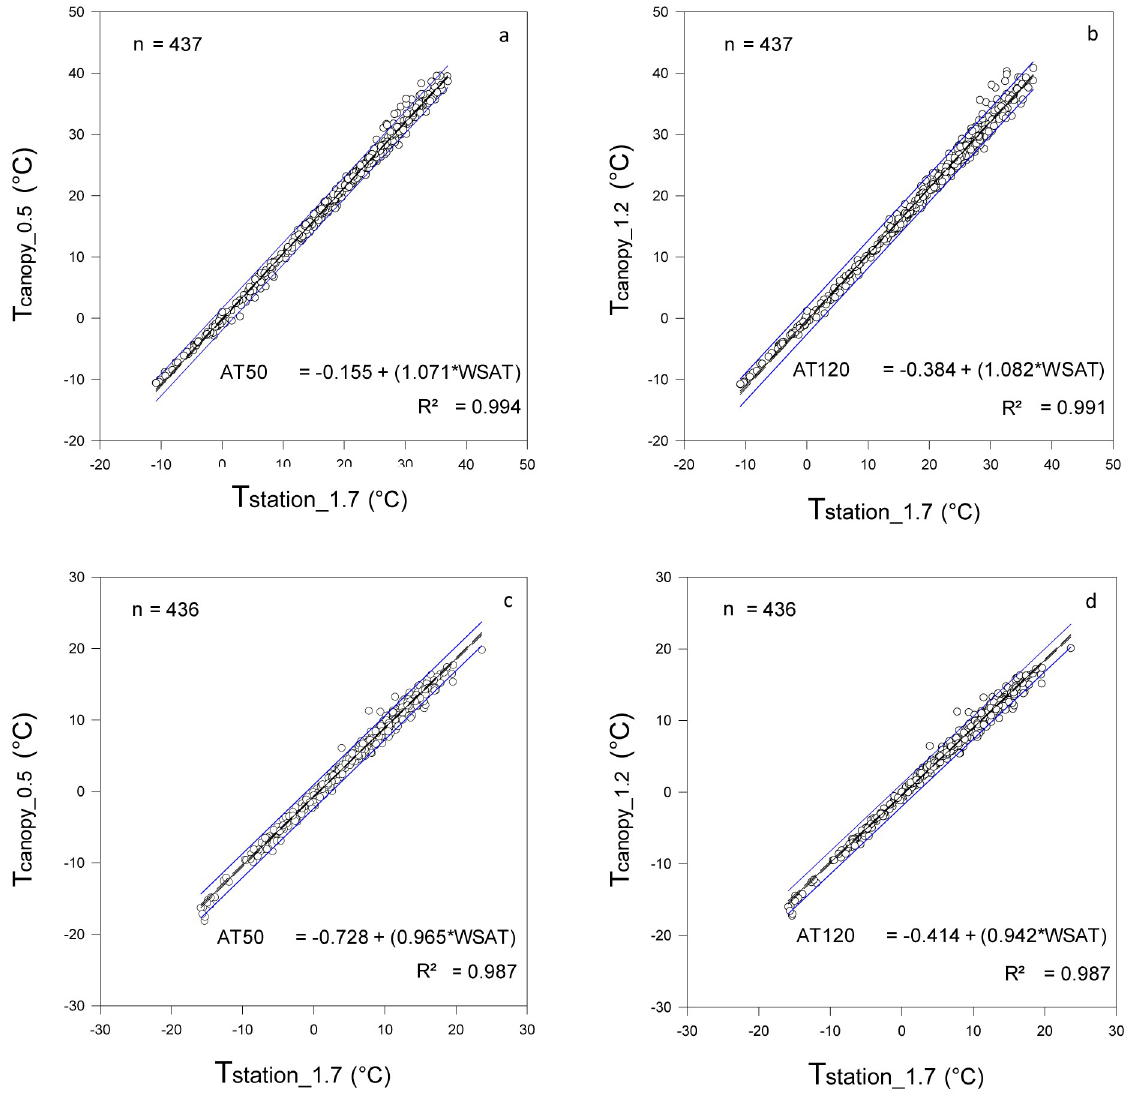
Fig 5. Linear regression between daily maximum (a and b) and minimum (c and d) air temperature measured at the weather station (T station_1.7 ) and within the canopy of the vineyard at a height of 0.5 m (T canopy_0.5 ) and 1.2 m (T canopy_1.2 ) above the soil